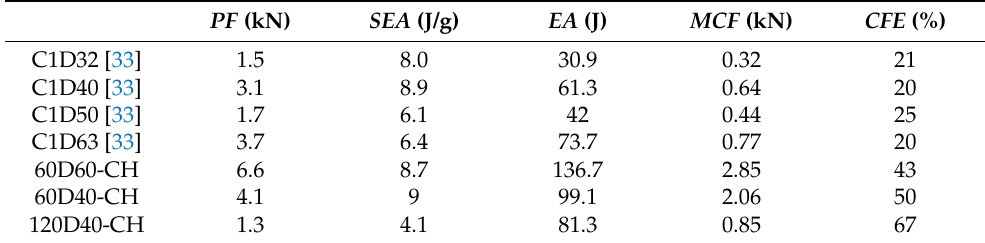
Table 4. Summary of crashworthiness indicators of specimens and previous research